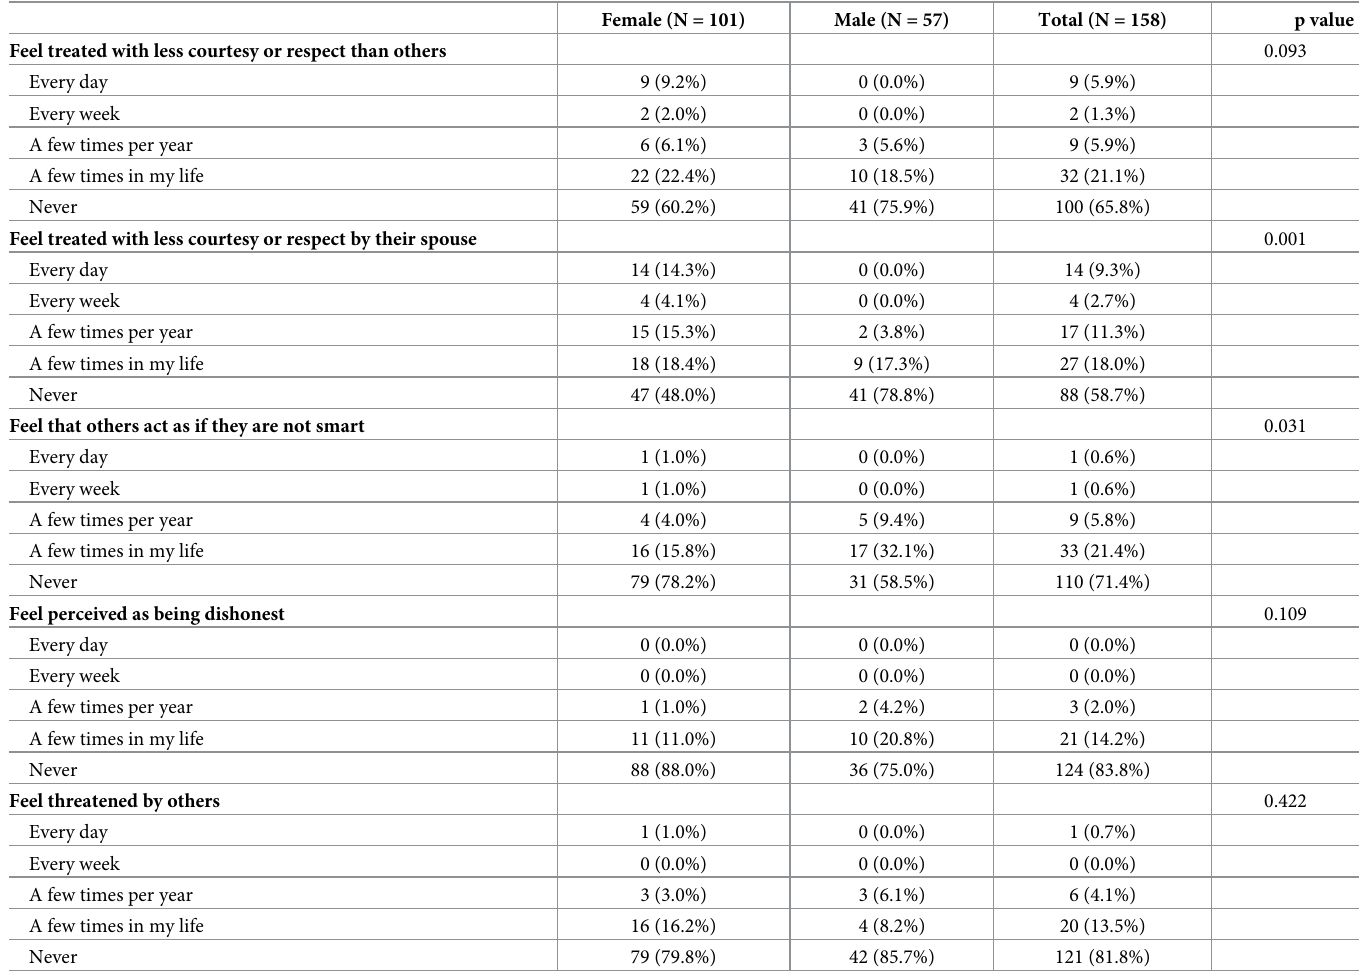
Table 3. Adapted everyday discrimination scale by